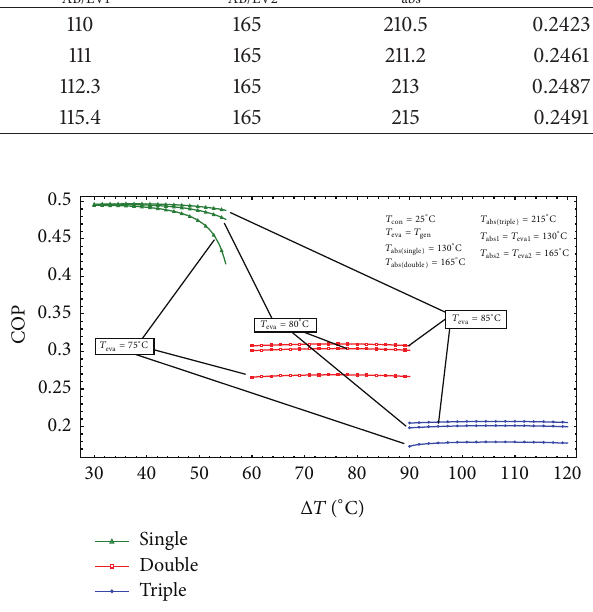
Figure 16: Effects of GTL on COP for different types of AHTs at different evaporation temperatures